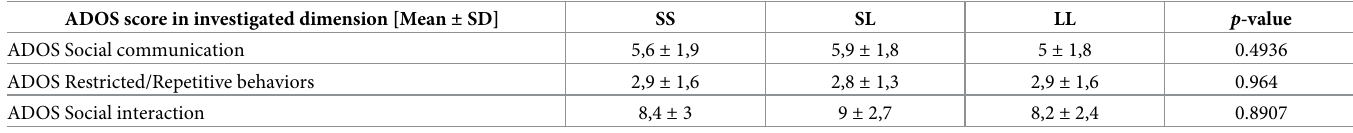
Table 2. Phenotypic